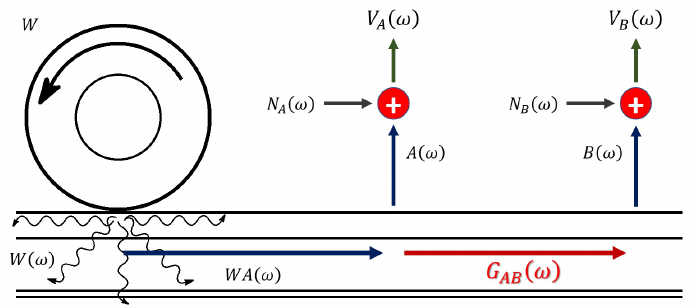
Figure 13. Representation of the linear wheel-rail interaction in the frequency domain